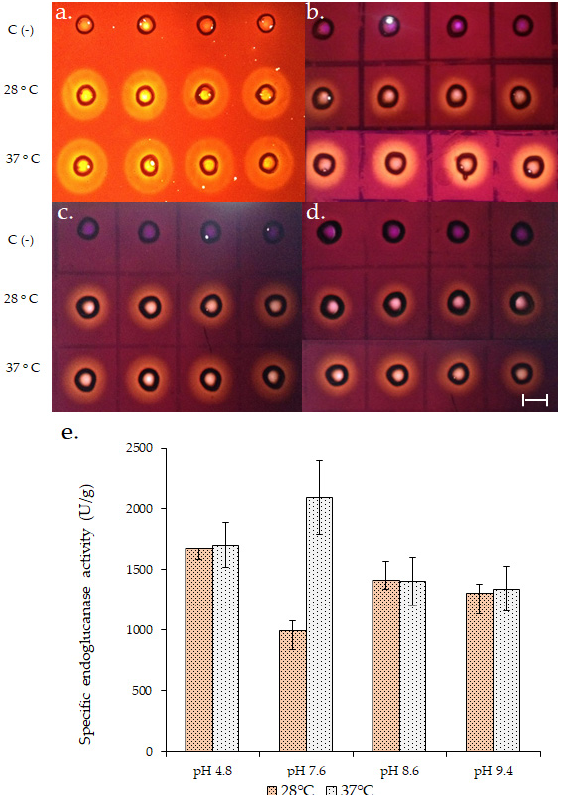
Figure 1. Endoglucanase activity (EG) of A. fumigatus LMB-35Aa biofilms developed on polyester cloth at 72 h of growth and 28 or 37 °C. The upper panel shows a qualitative assay for EG at ( a ) pH 4.8; ( b ) 7.6; ( c ) 8.6 and ( d ) 9.4. C (-) represents the negative control for the assay. Specific EG activity ( e ) was calculated by quantitative assay. Specific activity = EG (U/L)/soluble secreted protein (g/L). Scale bar represents 1 cm.